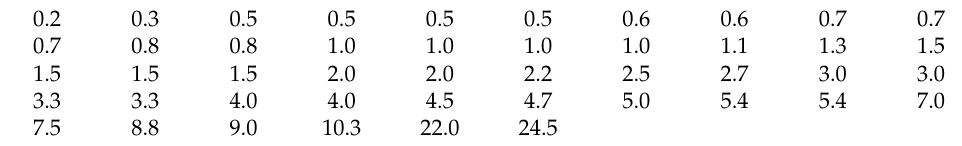
Table 4. Repair times (in hours) for airborne transceivers.